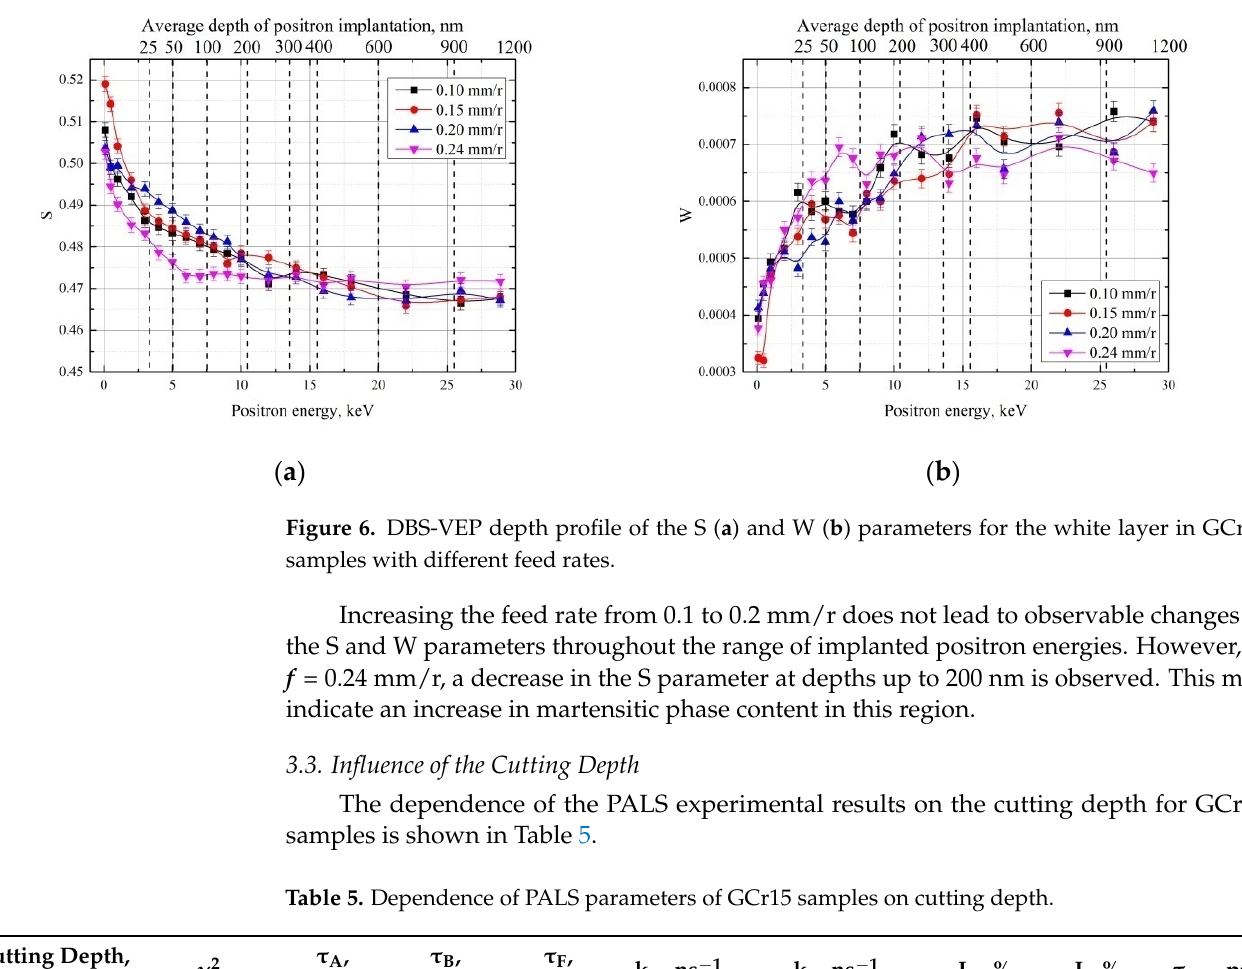
( b ) Figure 5. Dependencies of S (black) and W (blue) parameters ( a ) and average positron lifetime ( b ) as a function of feed rate for GCr15 steel.